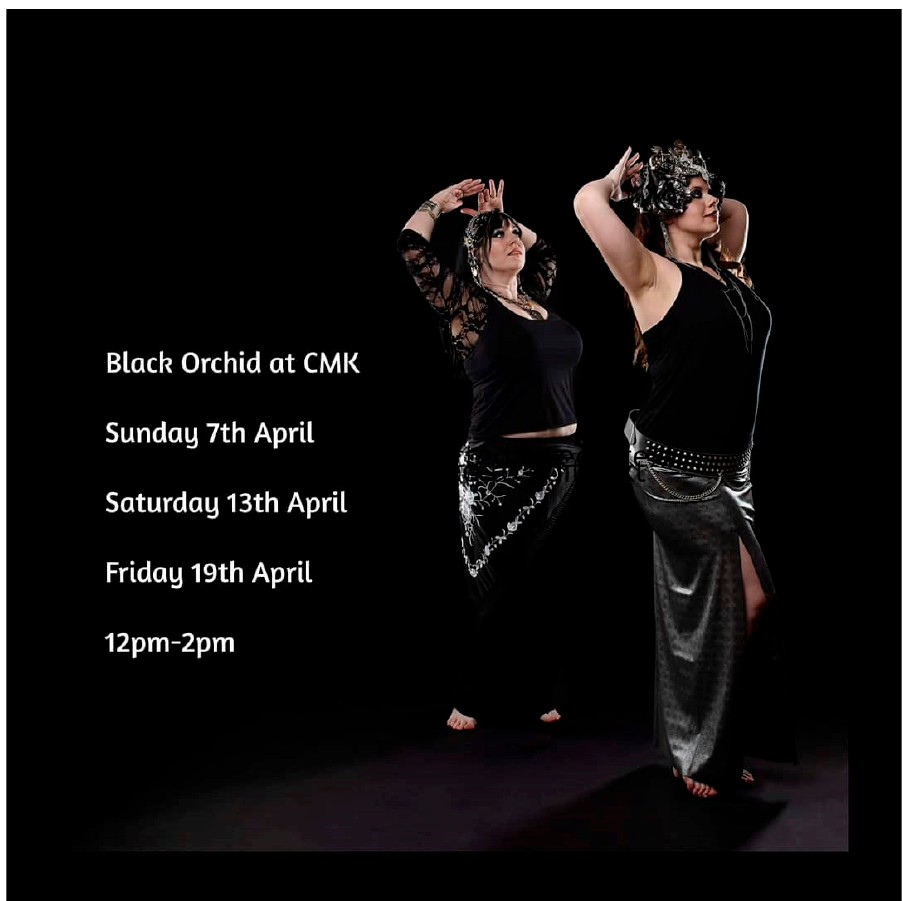
Figure 1. A poster advertising the performances of a duo of community performers called ‘Black Orchid’ at Centre MK. Courtesy of BCA.